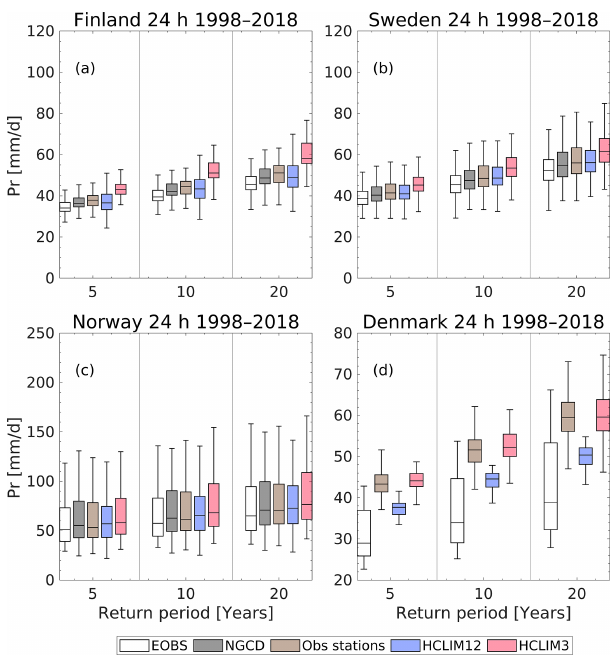
Figure 4. Same as in Fig. 3 but for daily return levels in (a) Finland, (b) Sweden, (c) Norway, and (d) Denmark in HCLIM12, HCLIM3, and observational datasets. The label of Obs stations refers to the AM